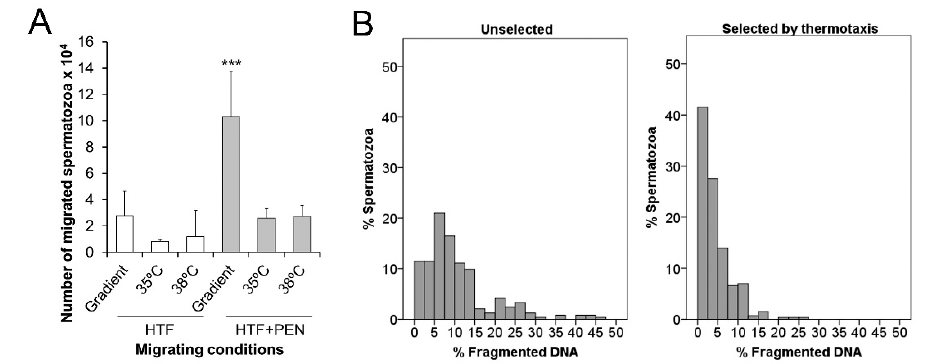
Figure 4. Sperm selection by thermotaxis. ( A ) The number of spermatozoa in vitro migrating from 35 to 38 °C or across a constant temperature (35 or 38 °C) for 60 min after 30 min of incubation in synthetic human tubal fluid (HTF) or HTF supplemented with 750 µM of penicillamine (HTF + PEN). The initial number of spermatozoa loaded in the thermotaxis system was between 5 and 6 × 10 6 per separation. ( B ) Histograms show the distributions of % fragmented DNA in individual spermatozoa unselected or selected by thermotaxis after incubation for 30 min in HTF + PEN. *** p = 0.009, n = 6.